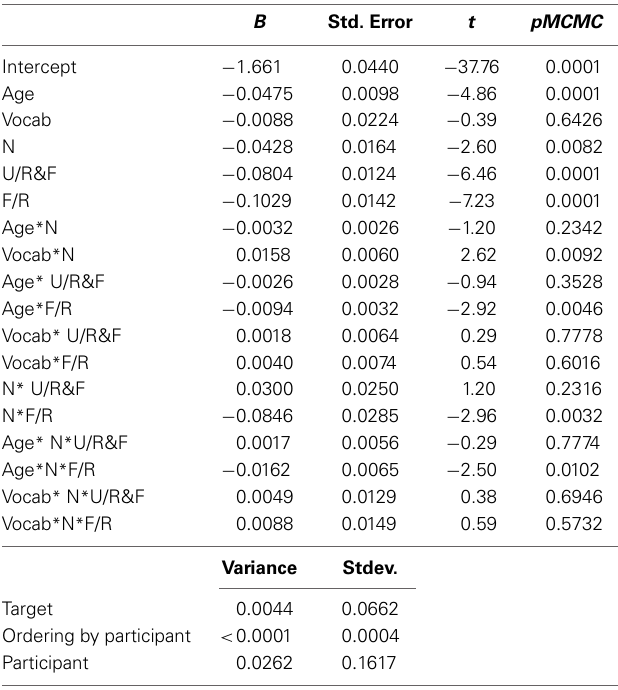
Table 7 | The coefficients and their significances in the model that tested the predictive power of effective N.